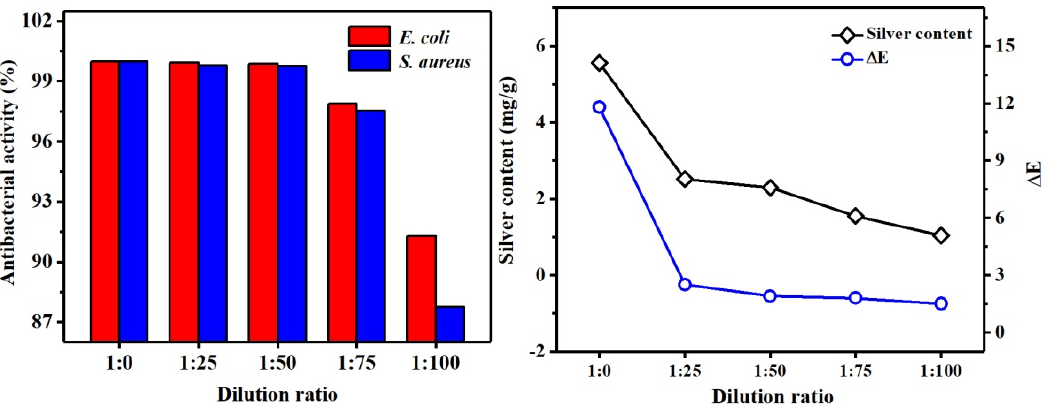
Figure 12. Under different dilution ratio of Ag/Cotton, the antibacterial rate ( left ), silver content and ∆ E ( right ). Antibacterial and Washing Resistance